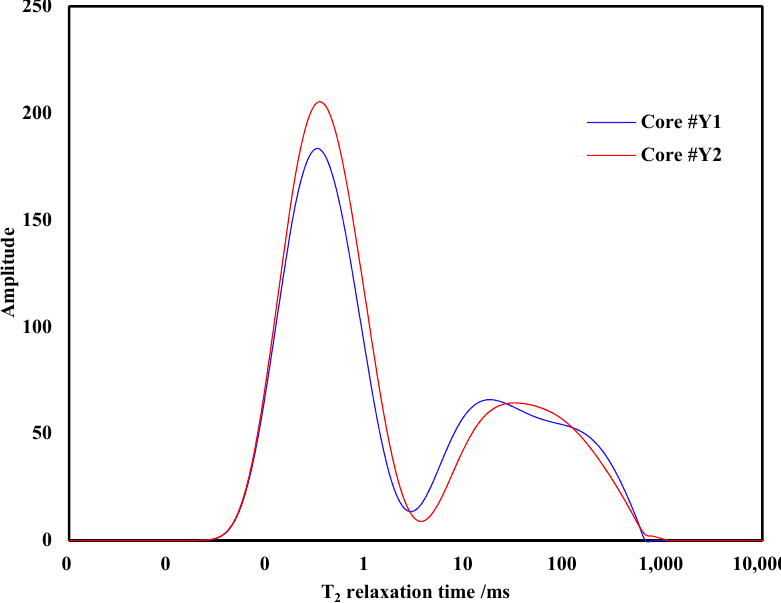
Figure 6. T 2 spectrum curves of initial saturated oil in cores.